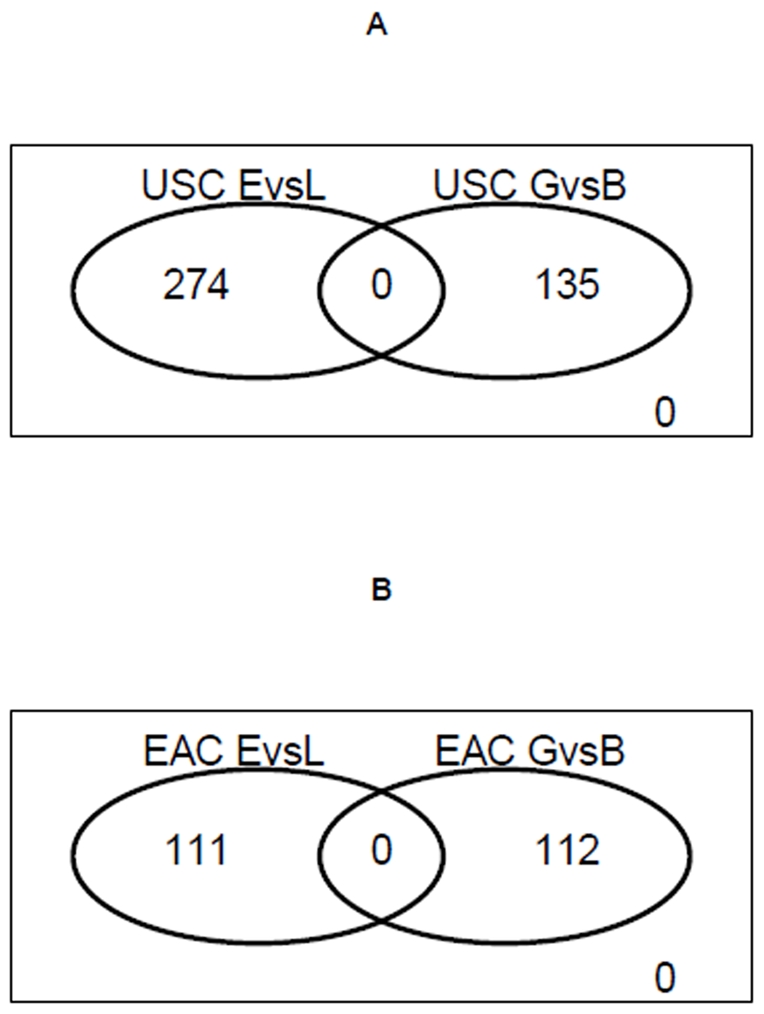
Venn diagrams show no overlap between stage-related DEGs (late versus
early) and outcome-related DEGs (good versus poor) in both USC and EAC
groups.
EvL means DEGs from comparing late stage versus early
stage patients. GvB means DEGs from comparing good
prognosis versus poor prognosis patients. A) DEGs as defined by
P-value<0.01 in USC group. B) DEGs as defined by P-value<0.01 in
EAC group.